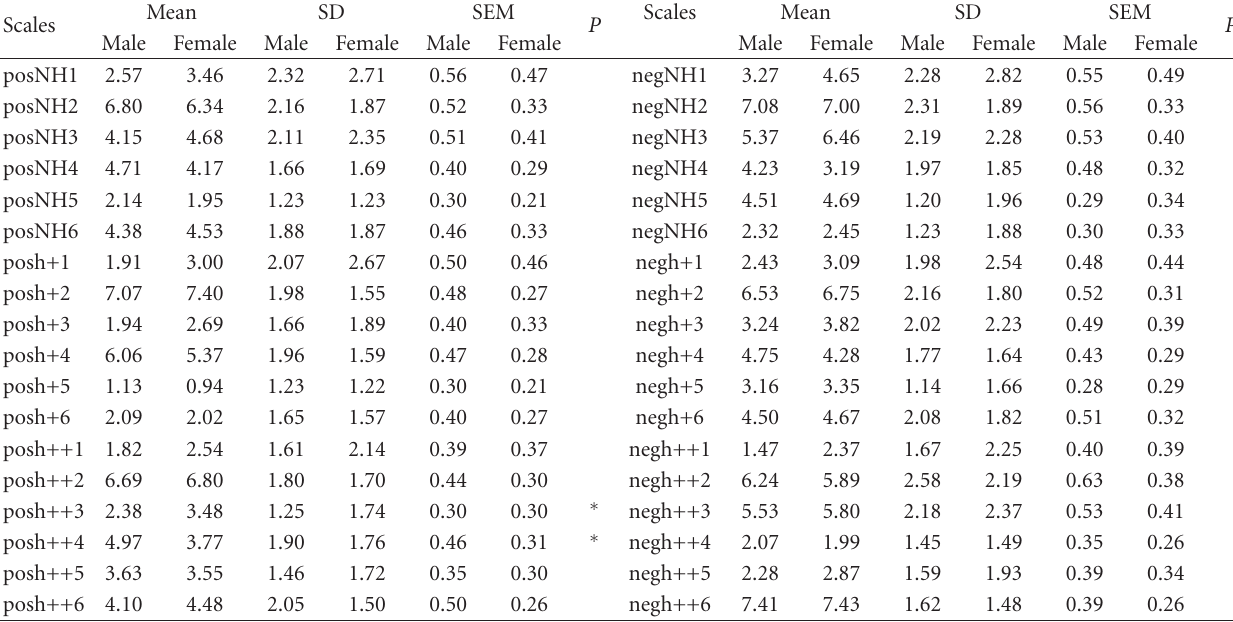
Table 1: Gender di ff erences in the subscales of the QDF (means, SD, SEM, and significance of di ff erences P ).